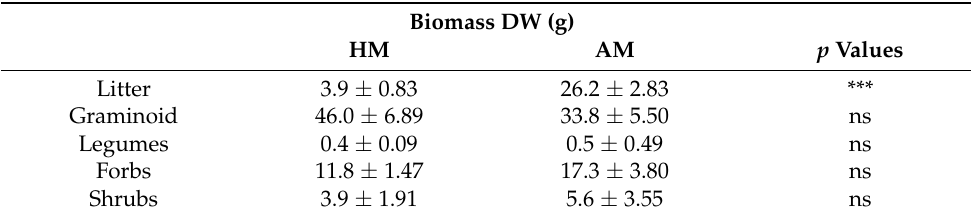
Table 2. Plant biomass of functional types and litter in hay (HM) and abandoned (AM) meadow. Data are means of 16 samples ± SE. Asterisks represent significance of p < 0.05; *** = p < 0.001; ns = not significant, calculated by ANOVA with nested factor (blocks have been considered as random